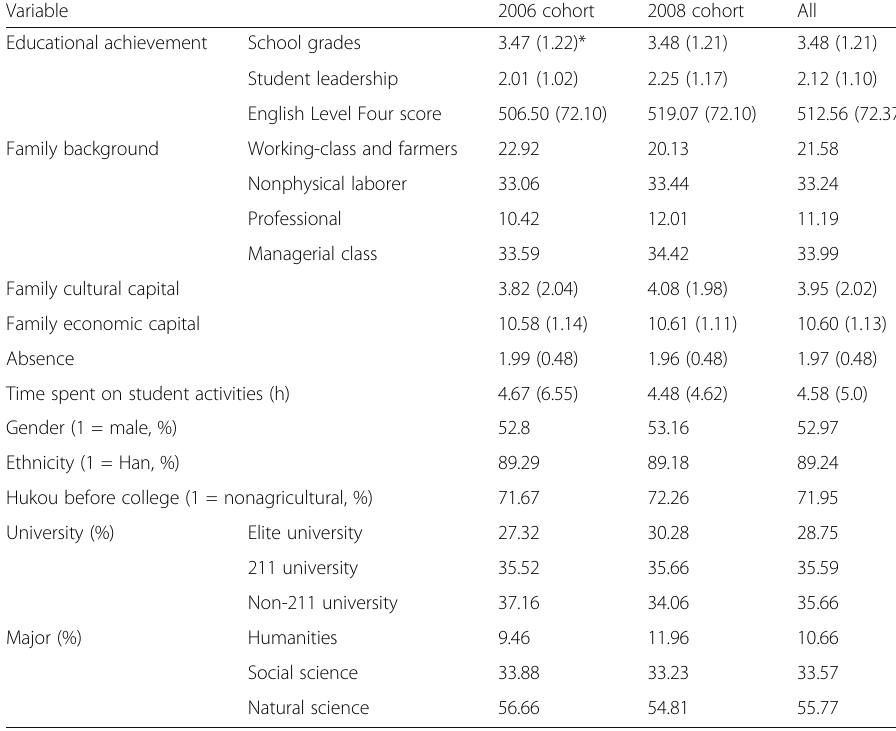
Table 2 Descriptive statistics of relevant variables ( N = 4004)